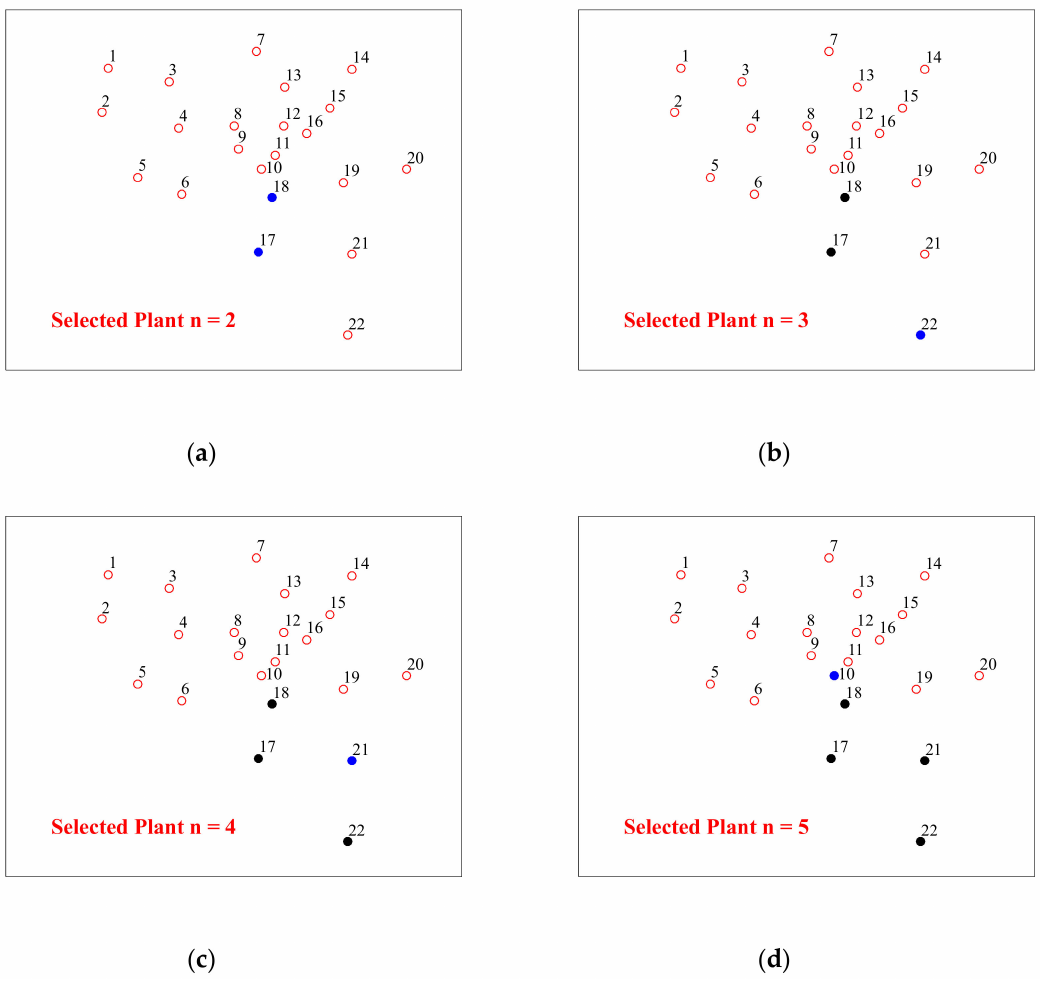
Figure 9. Selection process of the representative power plant in sub-region 4. ( a ) when the selected number is 2; ( b ) when the selected number is 3; ( c ) when the selected number is 4; ( d ) when the selected number is 5.